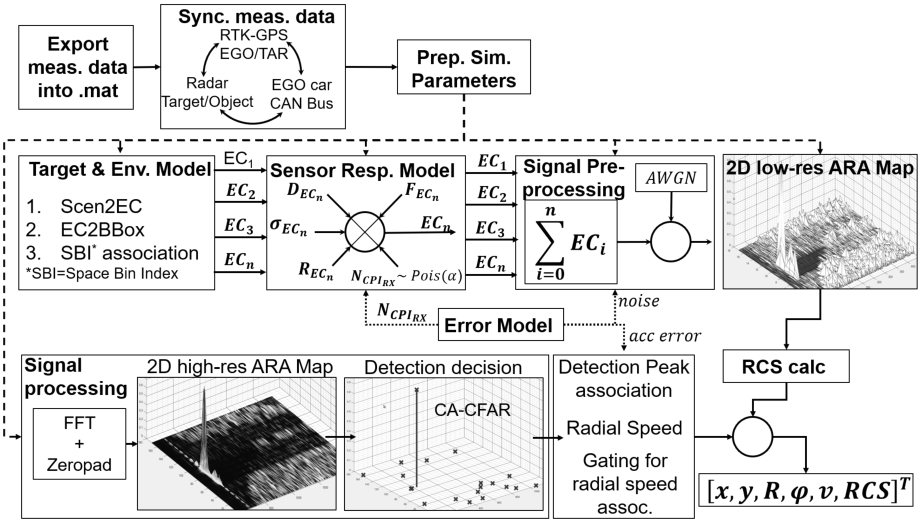
Figure 6. Implementation of the model.